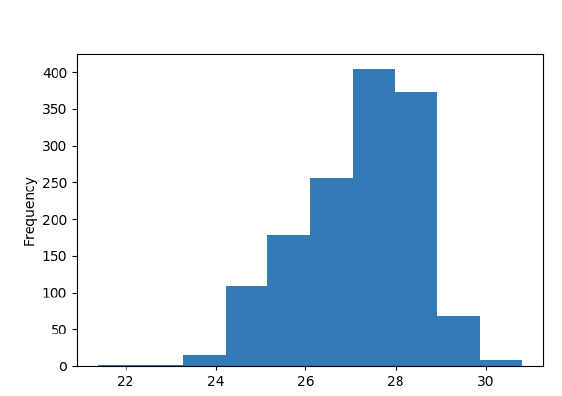
Figure 1. Average value of precipitation, mm